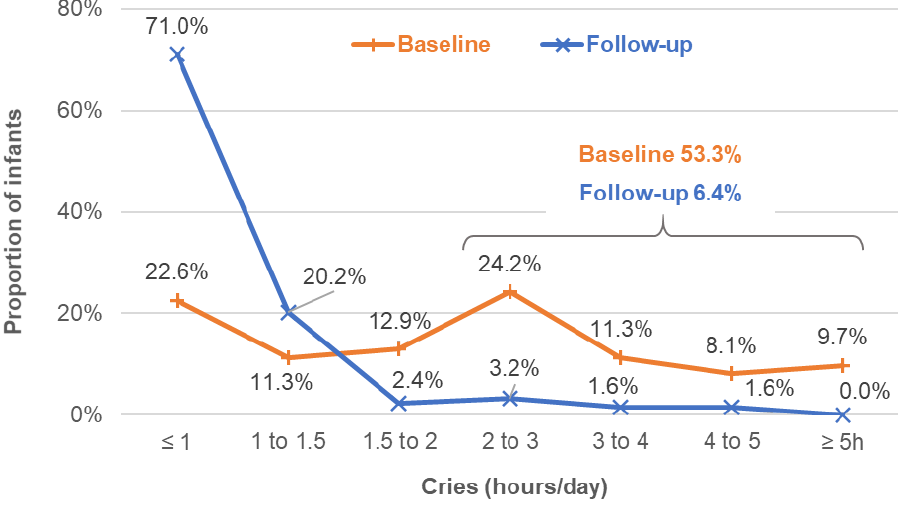
Figure 5. Breakdown of infants according to the frequency of crying per day at baseline and follow-up ( n = 124 infants non-IgE or mixed like type of CMPA).